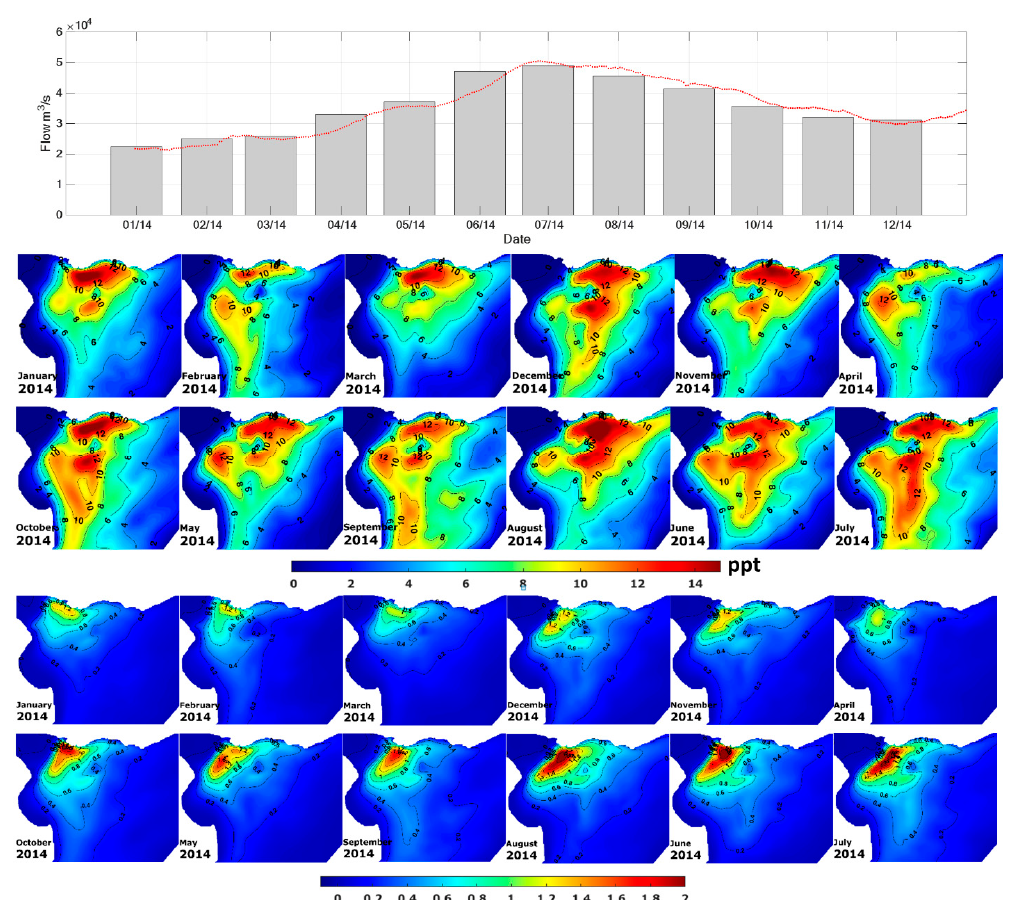
Figure 6. Upper panel: daily flow of the Uruguay and Parana rivers during 2014, with bars indicating monthly mean. Middle and lower panels: monthly mean salinity stratification (ppt) and monthly mean normalised salinity stratification, respectively, obtained with the numerical model for 2014, and ordered according to increasing monthly average river flow. All maps are in geographic coordinates between Lat ( − 36.9, − 34.7) and Long ( − 57.4, 54.2).